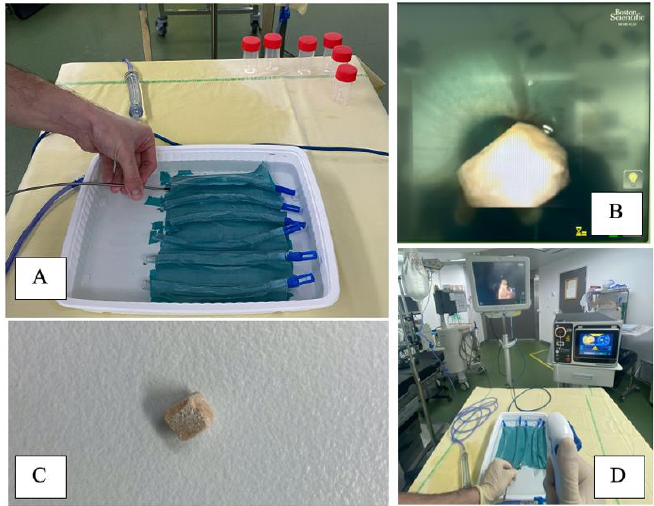
Figure 1. Experimental set up showing ( A ) Six polymer tubes, 17 cm length, closed on one side, 7 mm diameter, with an opaque tape on a tray with saline, used as a ureteral model ( B ) Endovision of the ureteral model with a Lithovue (Boston Scientific ® , Maple Grove, MN, USA) and a BegoStone on it ( C ) BegoStone 5 × 5 × 5 mm 3 , dry weigh before and after the tests ( D ) Room display, using a Lithovue (Boston Scientific ® , Maple Grove, MN, USA). Irrigation was ensured by a combination of a gravity irrigation at 40 cmH 2 O above the saline tray and a hand-assisted irrigation